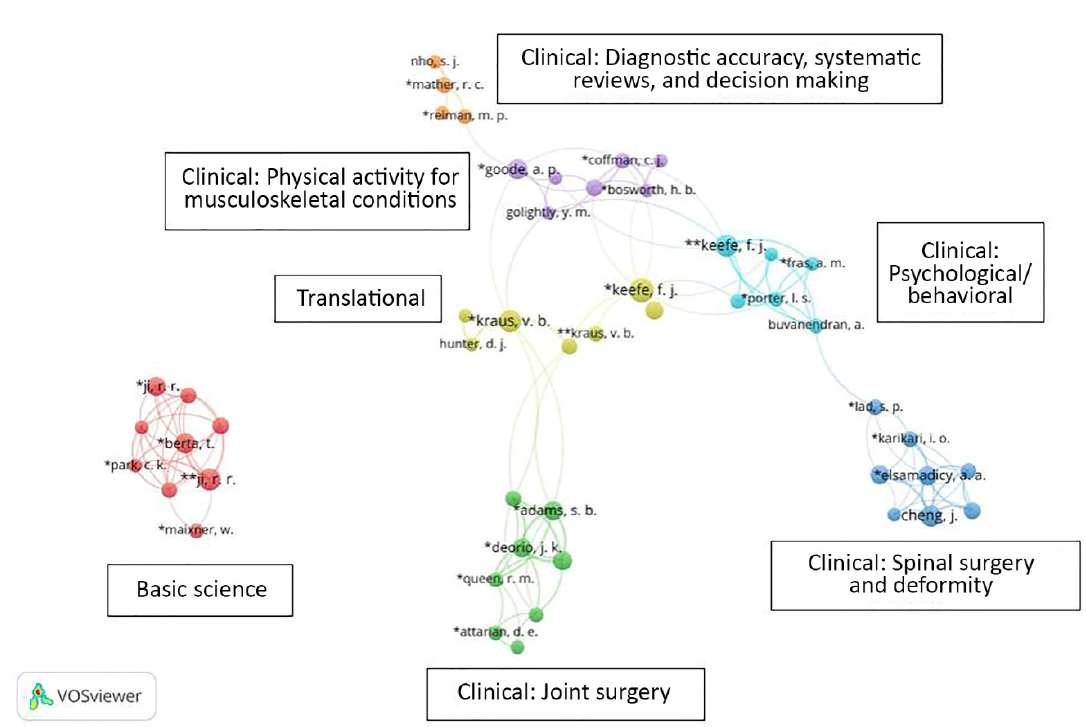
Figure 3 Clusters based on domain knowledge and awareness of Duke author subject